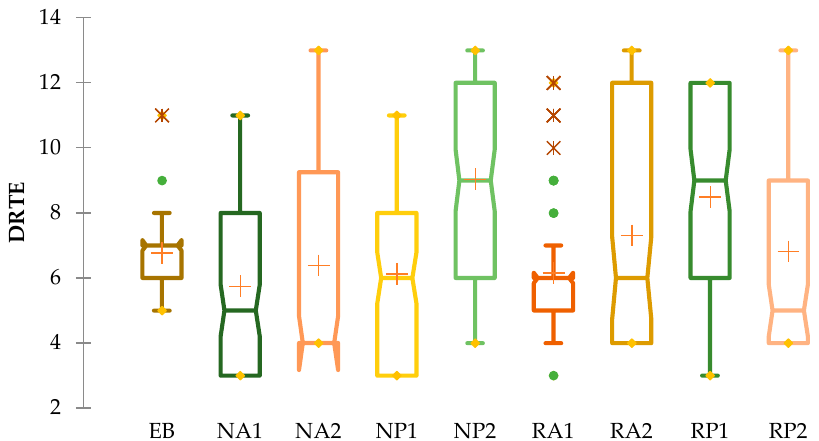
Figure 5. Ripening heterogeneity results of Hass avocados. Orchards: EB, N, and R. A: Nutrient management-based program on the Balanced Indices of Kenworthy (BIK) standards. P: Nutrient management of the farmer. 1. Harvest from the intermediate flowering period. 2. Harvest from the main flowering period. DRTE: Days to ready-to-eat. The crosses represent the mean values, the yellow dots indicate the minimum and maximum values, and the green dots and brown asterisks denote outliers.